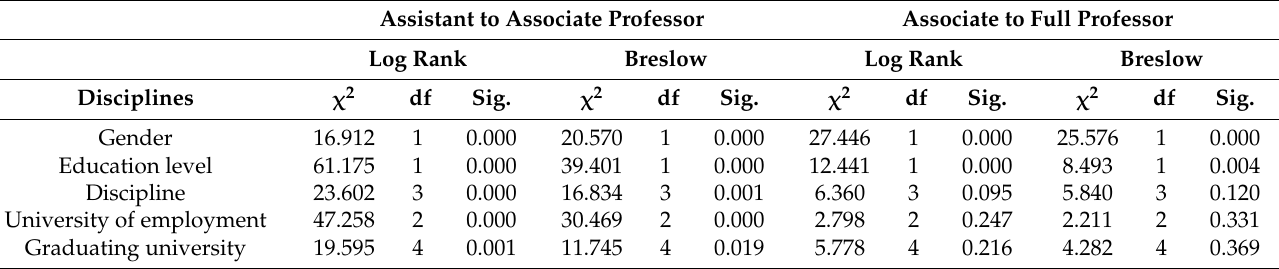
Table 3. Univariate Analysis of the Duration of the